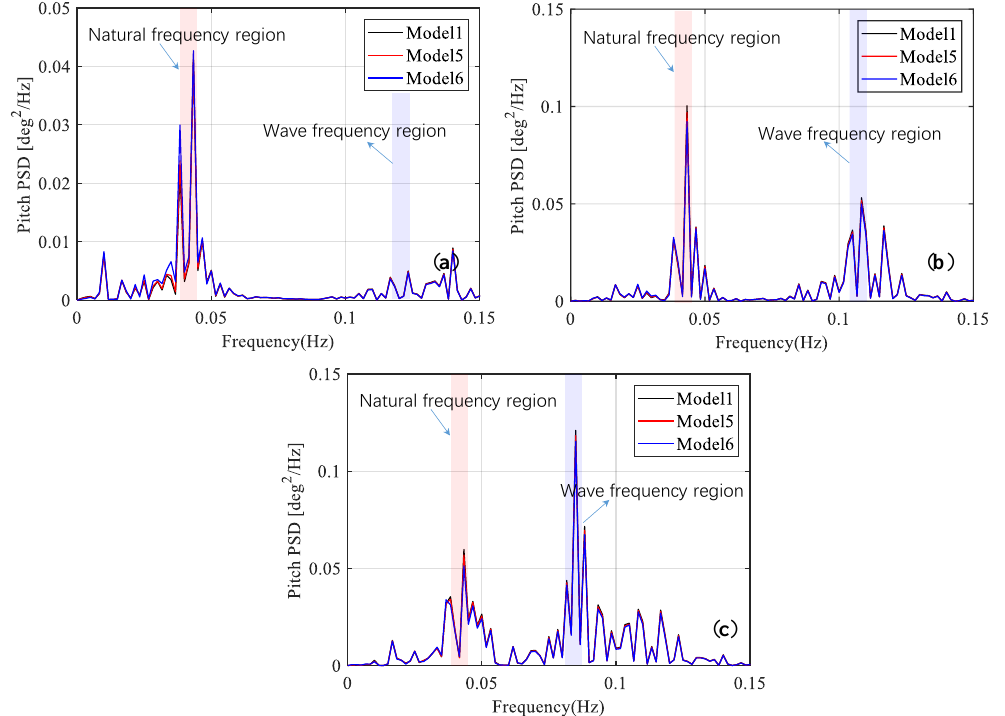
Figure 19: Frequency domain curves of the pitch PSD of the inclined upper column models: ( a ) LC4; ( b ) LC5; and ( c ) LC6. Table 15. Surge, heave, and pitch PSD statistics of the inclined upper column models in the frequency domain. DOF